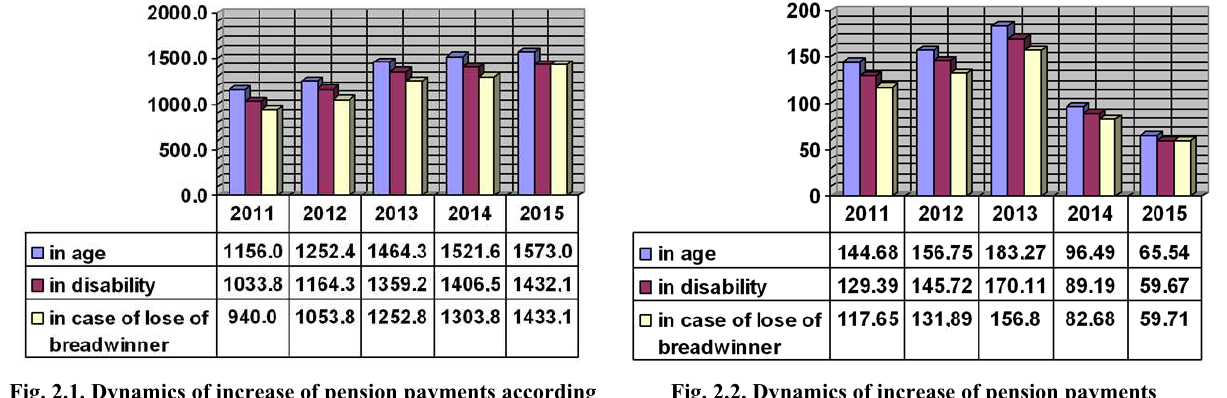
Fig. 2.1. Dynamics of increase of pension payments according to their types in Ukraine in the period of 2011-2015, hrn.